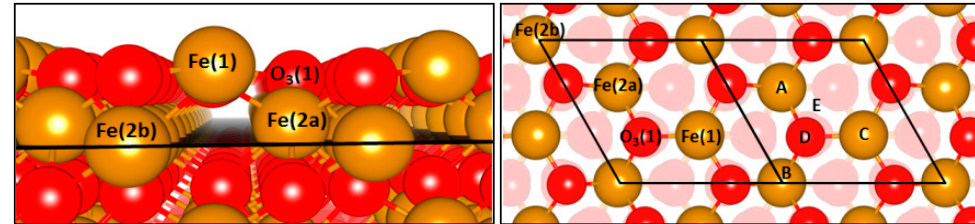
Figure 13. ( Left ) side view of the α -Fe 2 O 3 (0001) surface. The drawn plane marks the position of the semi-transparent oxygen ions; Brown sphere = Fe, Red sphere = O, ( Right ) view along the hexagonal axis of the α -Fe 2 O 3 (0001) surface. Different initial adsorption sites (from A to E) for the MoO 3 unit are shown; the rhombi represent the surface unit cell. Image adapted from J. Phys. Chem. C , 2014, 118 (45), pp. 26155–26161 [7].